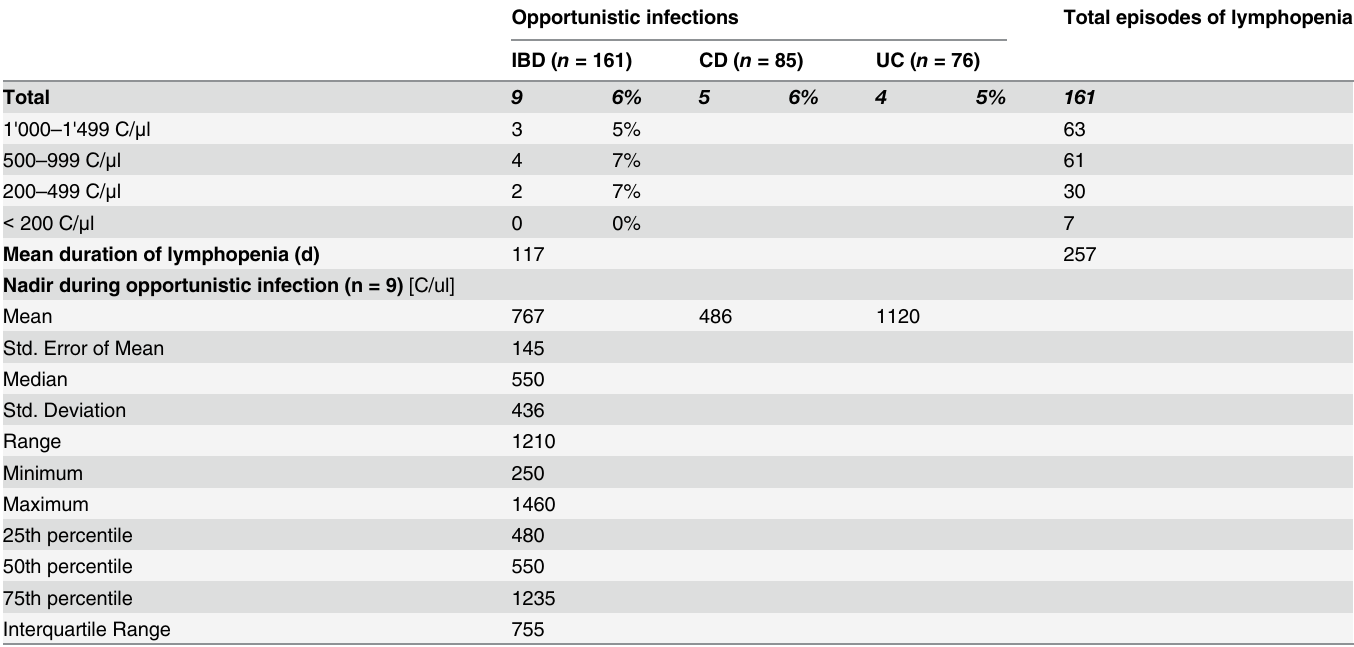
Table 5. Lymphopenia during opportunistic